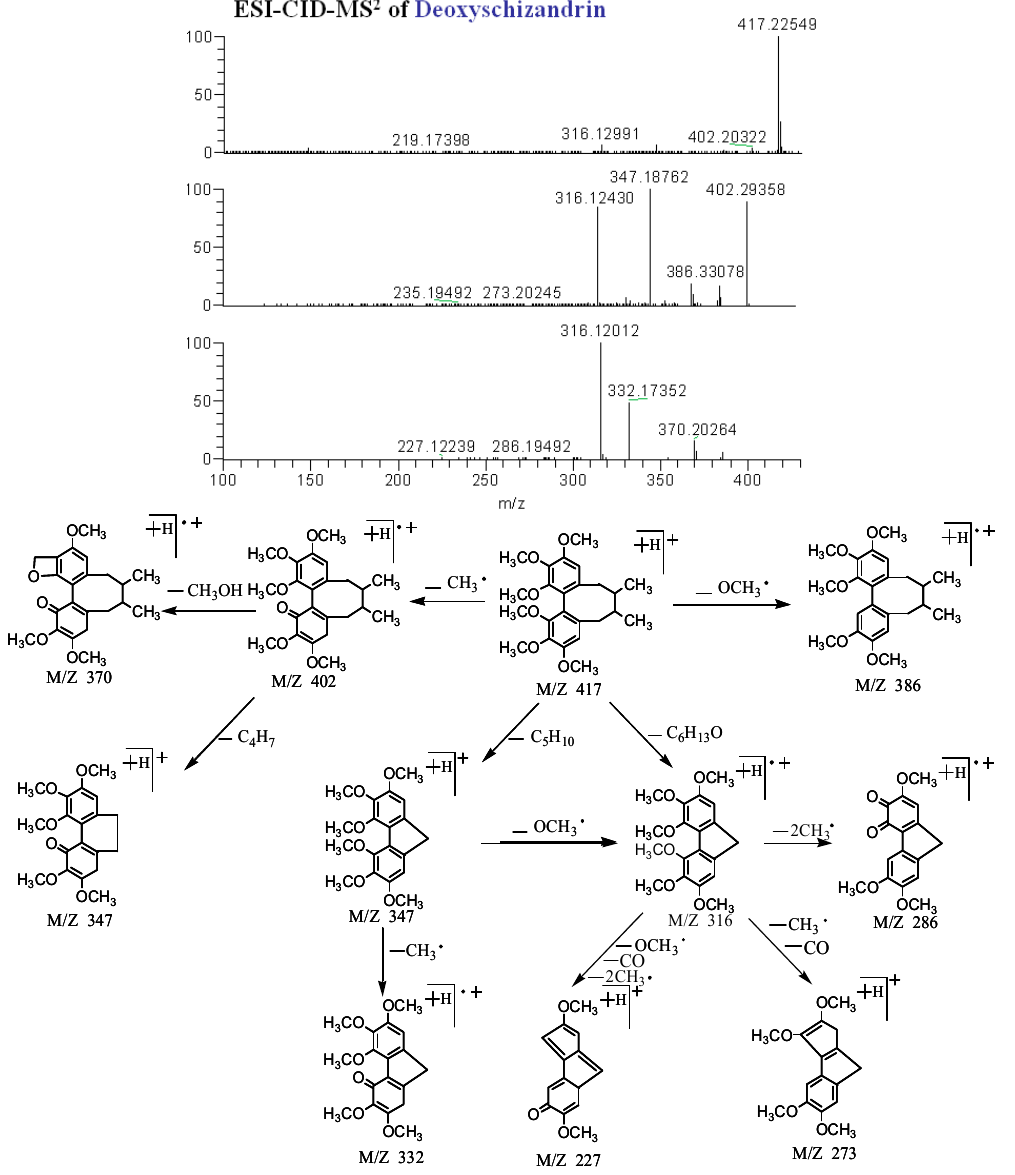
Figure 5. ESI-CID-MS 3 spectra and proposed fragmentations for deoxyschizandrin ( 102 ) from WZYZW.